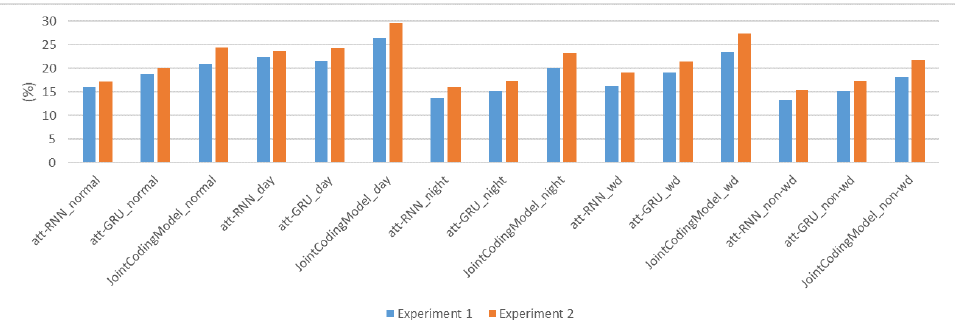
Figure 11. The results of MRR@20 with different dimensions in experiment 1 and experiment